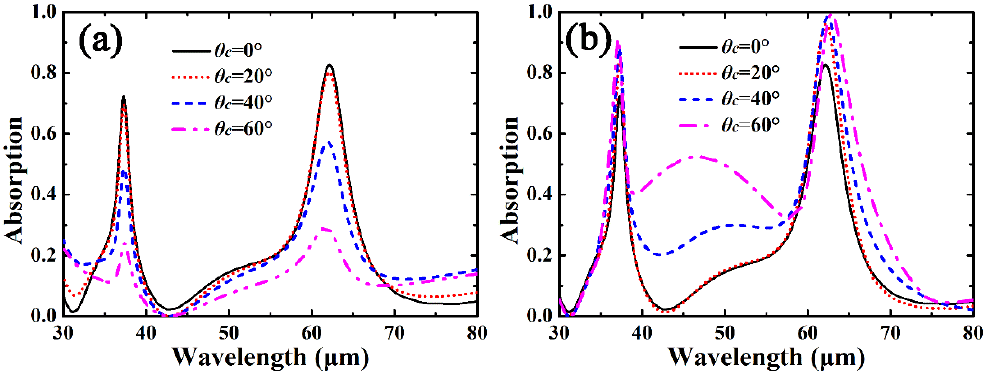
Figure 7. Absorption response of the cross-shaped graphene arrays as a function of the incidence angle for ( a ) TE and ( b ) TM polarizations. Other parameters are the same as those in Figure 3a.